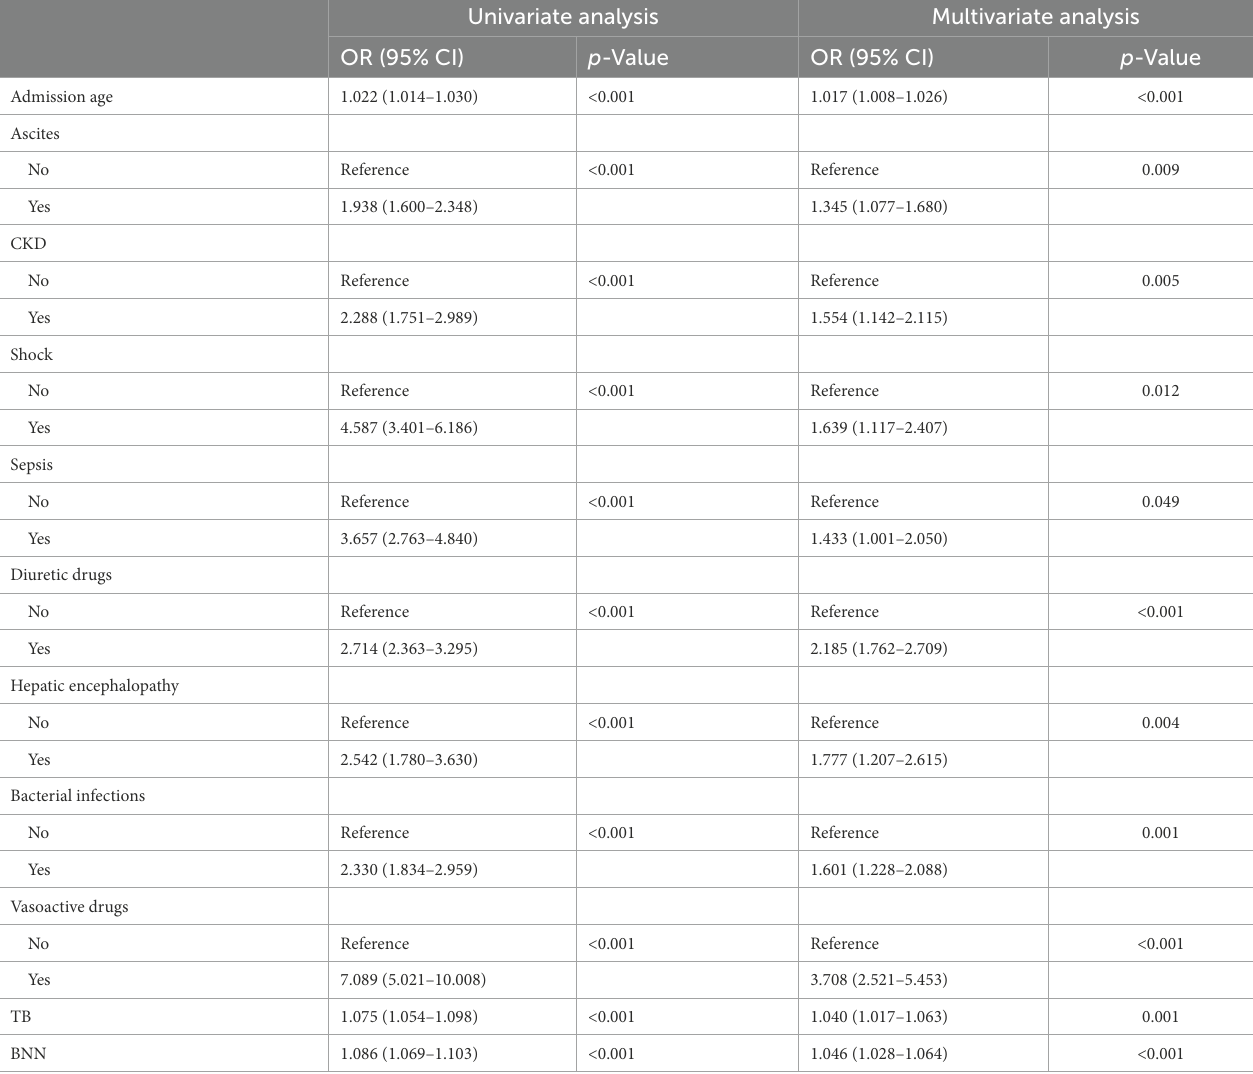
TABLE 2 Univariate and multivariate logistic regression analyzes of variables relating to AKI in the derivation cohort. Univariate analysis Multivariate